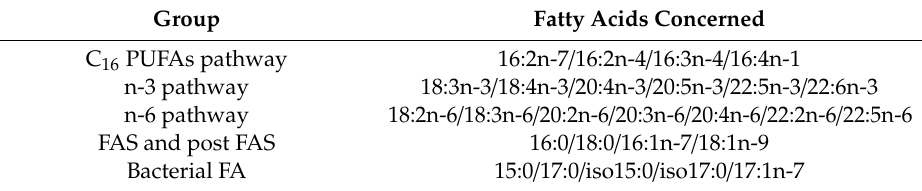
Table 2. Groups of fatty acids formed according to their main pathways. Group Fatty Acids